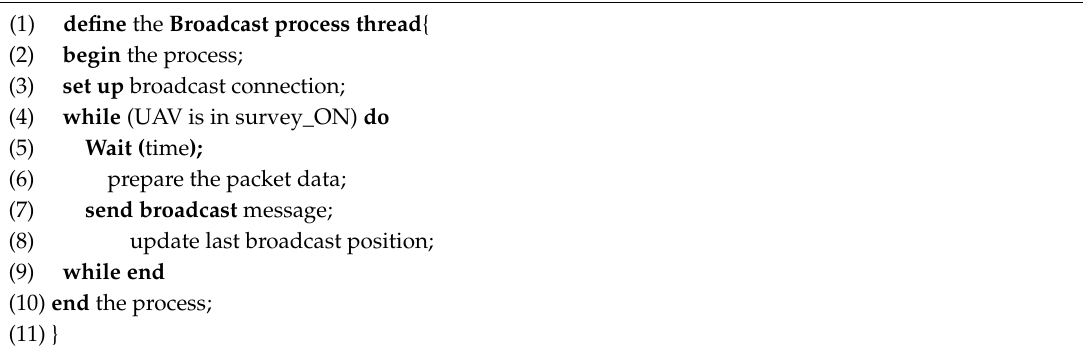
Algorithm 2 . Broadcast thread for UAV-WSN discovery (pseudo-code).